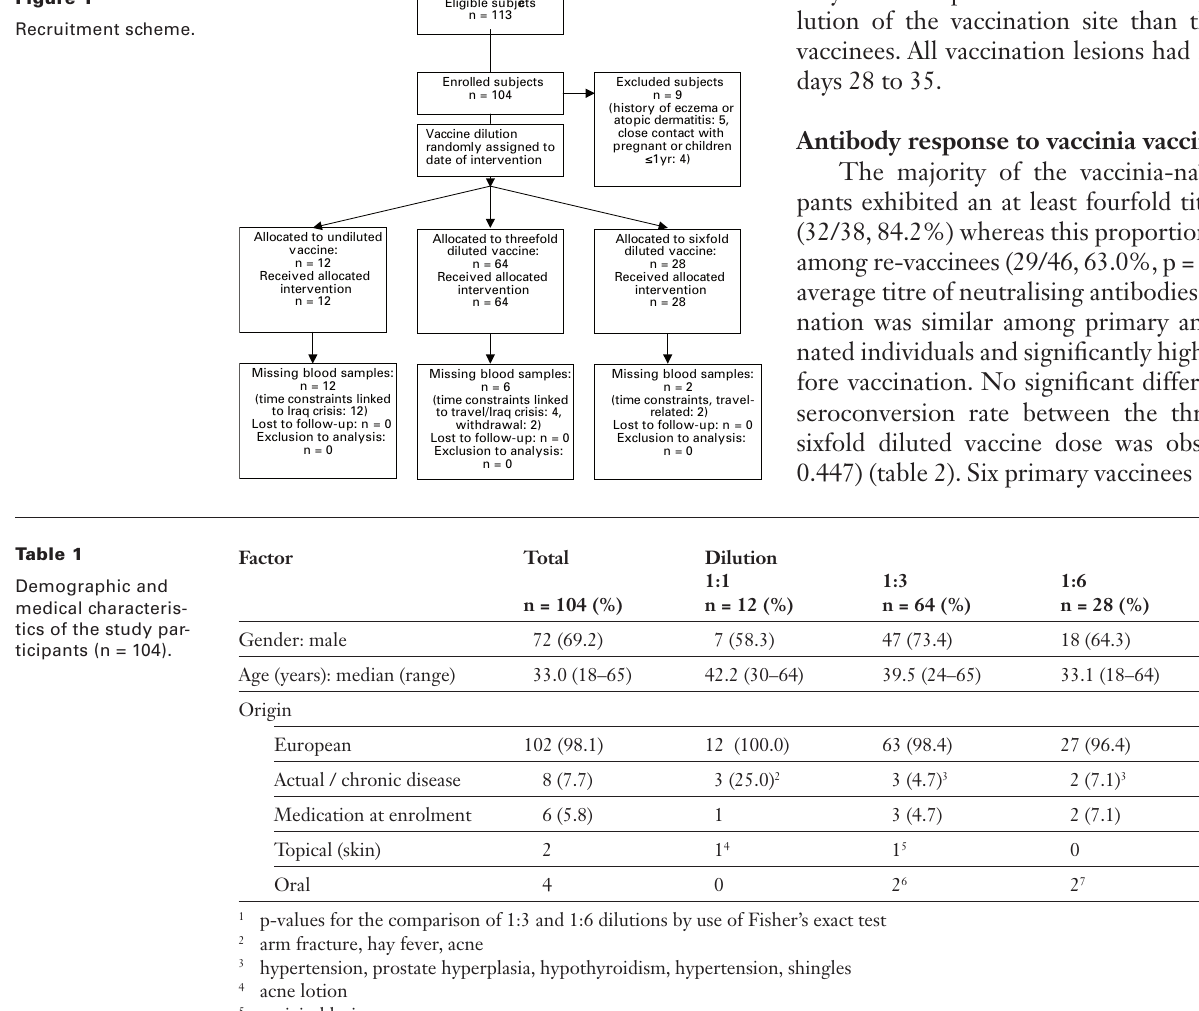
Recruitment scheme.